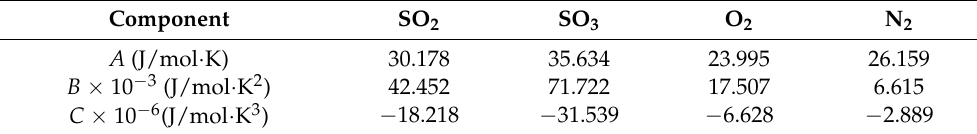
Table A1. Heat capacity